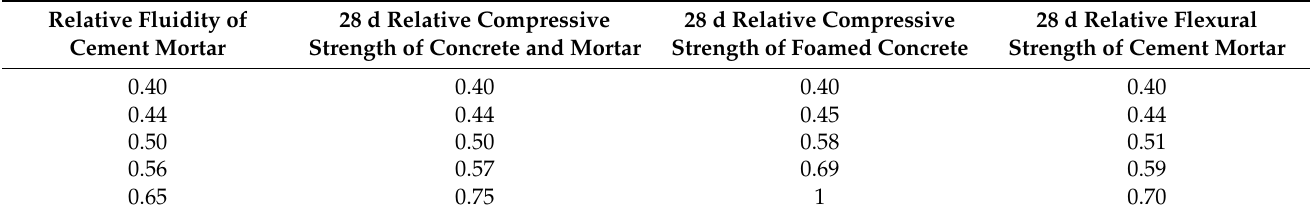
Table 6. Grey relational